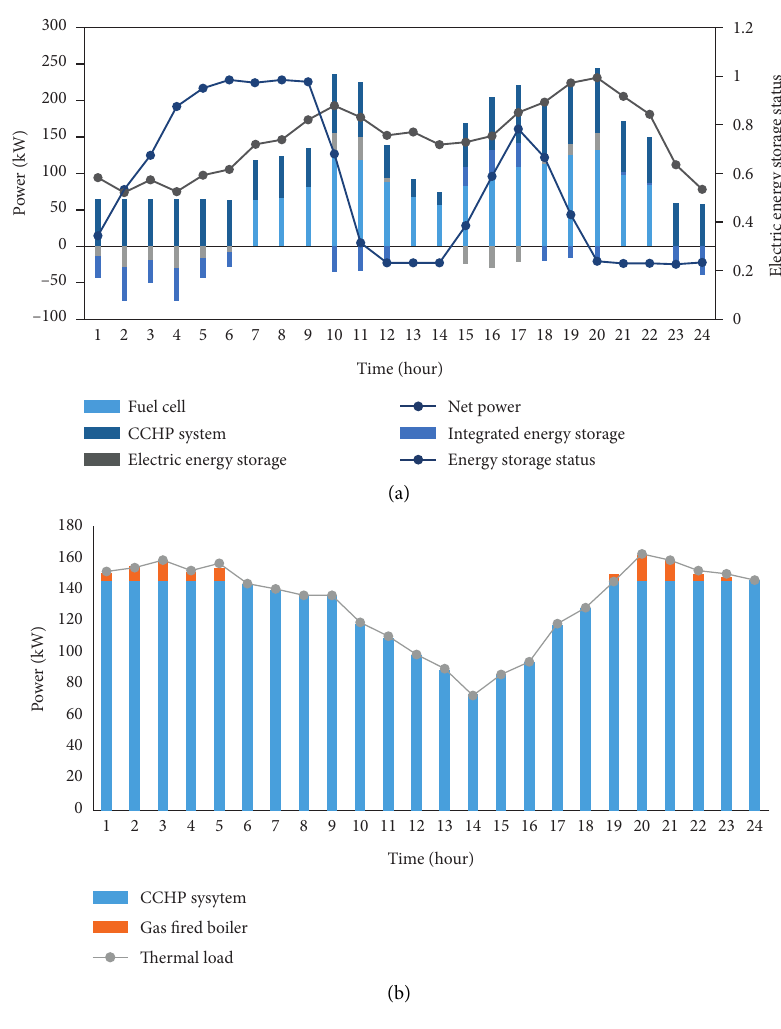
Figure 6: Optimization results in winter without heat pump and heat storage: (a) electric power; (b) thermal